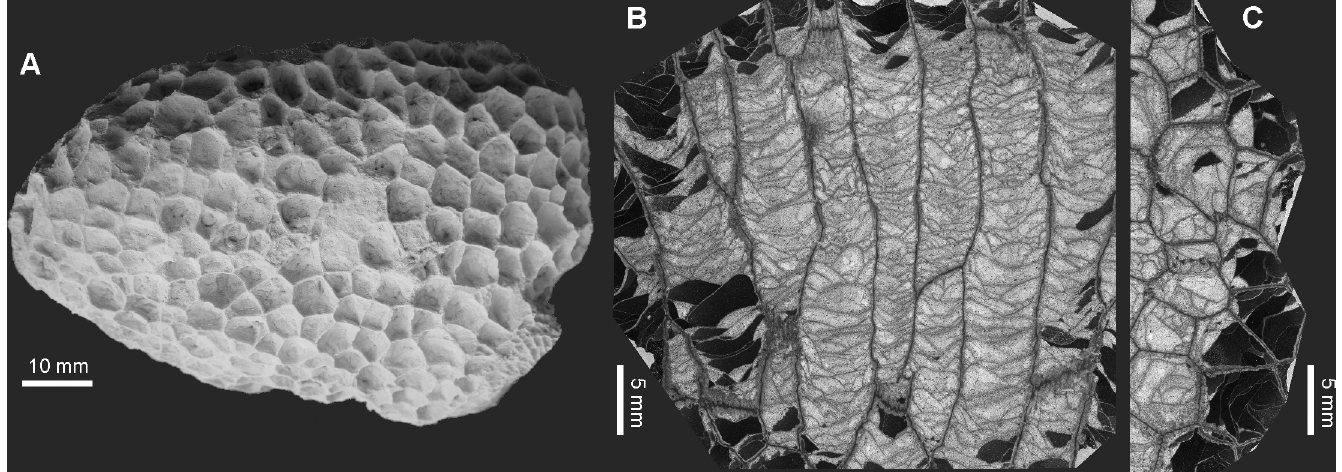
Fig 6. ? Michelinia vinni sp. nov. from Kowala Quarry, lithological set L, late Famennian. (A) External view of the corallum. (B) Longitudinal section. (C) Transverse section. Specimen GIUS 3619 KF 103,